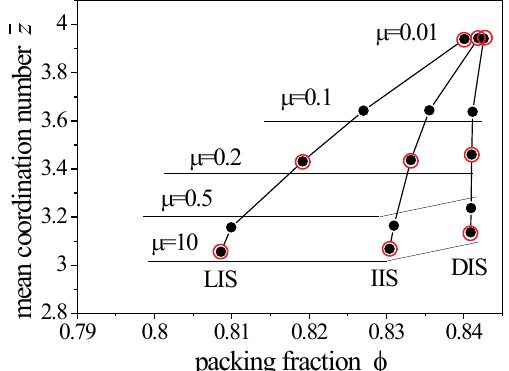
versus packing 𝒛𝒛